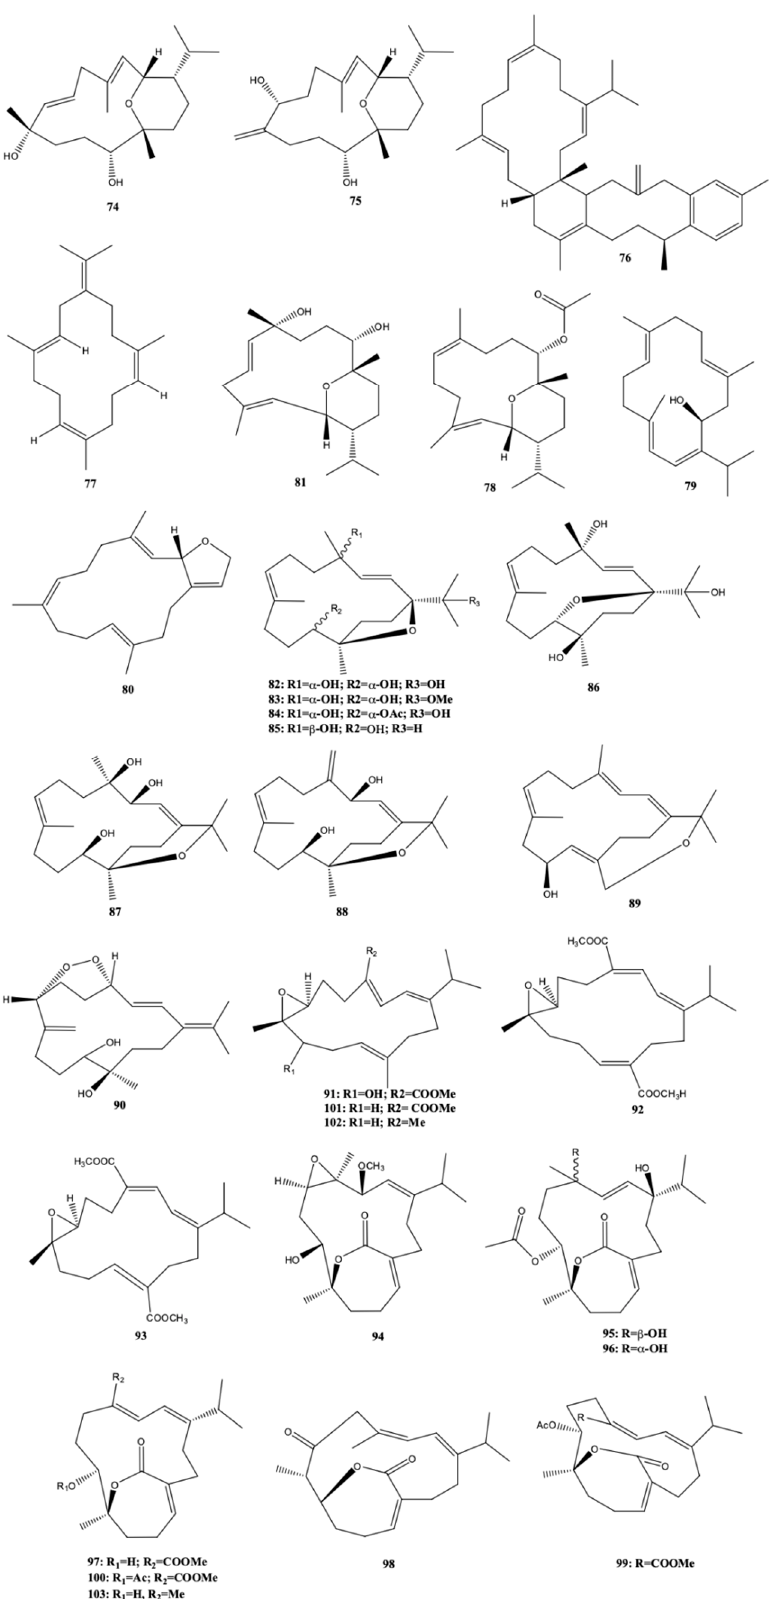
Figure 9. Cembranoid diterpenes isolated from S. trocheliophorum , from the Red Sea and South China Sea [23,25,28,34]. Six new cembranoids, cherbonolides A–E ( 104 – 108 ) and bischerbolide peroxide ( 109 ) (Figure 10) were isolated from the Formosan soft coral S. cherbonnieri , along with one known cembranoid,